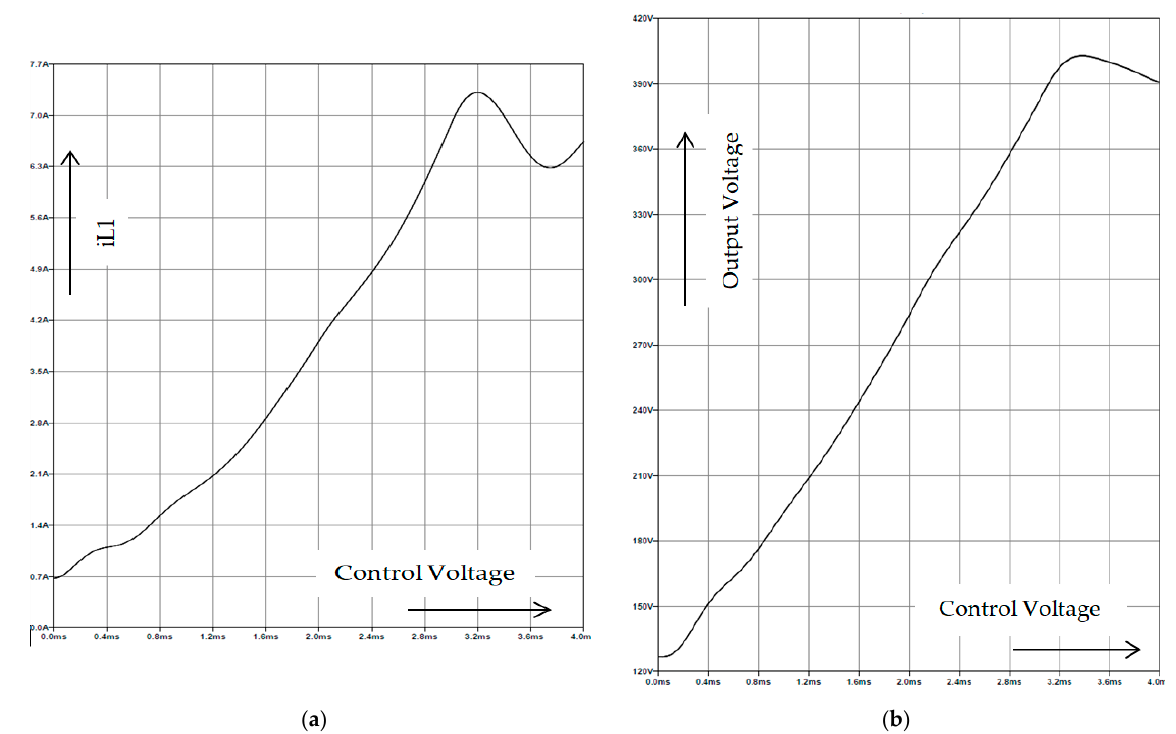
Figure 11. Variation of iL1 and V 0 with change in D (SEPIC). ( a ) Output Voltage Vs. Control Voltage, ( b ) Inductor 1 Current Vs. Control Voltage